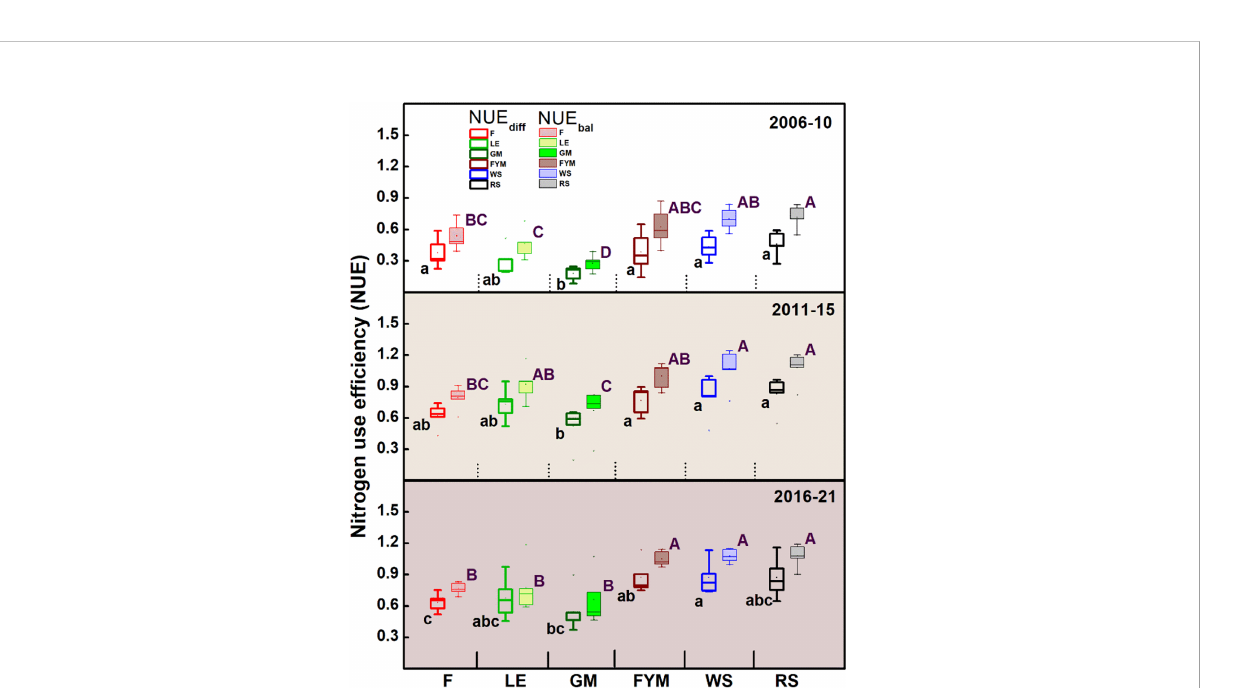
FIGURE 3 Trends in the nitrogen use ef fi ciency (NUE) for wheat crop during 15 years (2006-2021) of different nutrient management. Error bars denote ± 1SD. Different letters (capital for NUE bal and lower for NUE diff ) indicate signi fi cant differences for NUE (P ≤ 0.05). Refer to Figure 2 for the description of